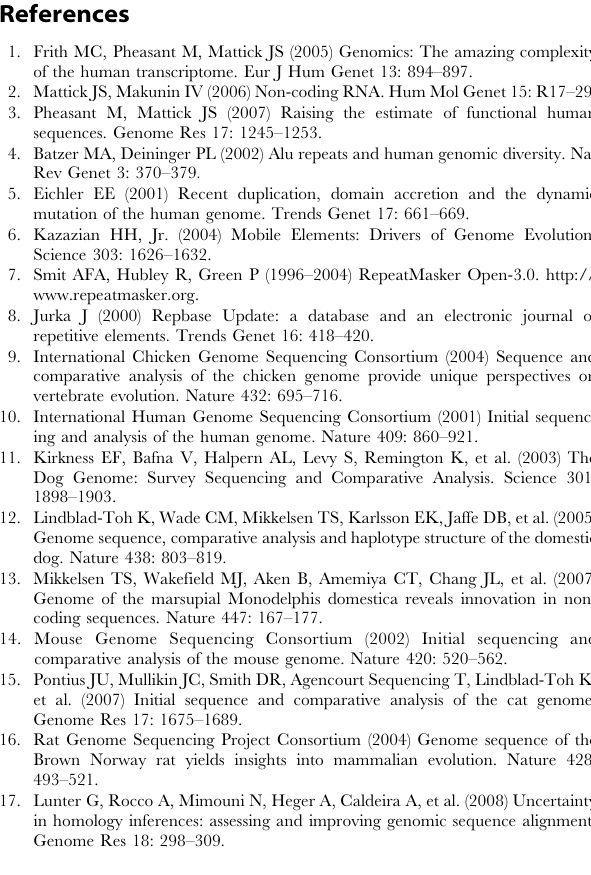
Table S7 Summary of the novel de novo P-clouds repeat predictions for the human genome (any overlapping RepeatMasker results subtracted), with length-dependent false positive estimates and expected true positives. (XLSX) Table S8 Details of Alu ESP analysis on the RepeatMasked portion of the human genome (with false positive predictions and expected true positives). (XLSX) Table S9 Details of MIR ESP analysis on the RepeatMasked portion of the human genome (with false positive predictions and expected true positives). (XLSX) Table S10 Overlap between genome features and repetitive regions. This is the same data as in Table 1, but in Mbp rather than percent of the category. These numbers are not adjusted for estimates of false positives in the P-clouds annotations. (DOCX) Text S1 Provisional URLs for UCSC genome browser tracks containing the de novo and element specific (for Alu and MIR ) P- clouds annotations of repetitive regions in the human